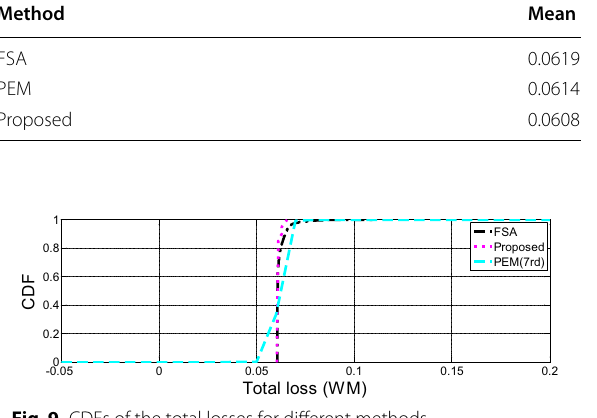
Fig. 9 CDFs of the total losses for different methods